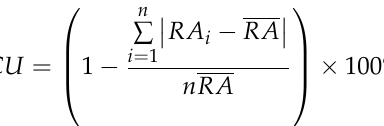
(cid:1827) represents the area of the measuring cup at the inner top edge in cm 2 . The diameter of the area is measured using a Vernier caliper with an accuracy of 0.02 mm.